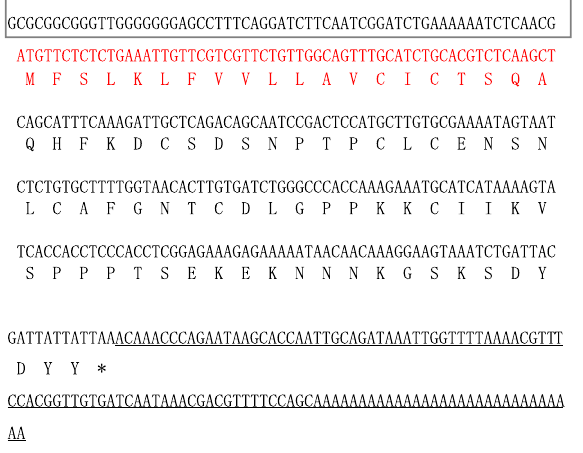
Figure 2. Full-length cDNA sequence of hirudin. (The signal peptide is marked in red; the initiation codon is shown in bold; the termination codon is indicated by an asterisk; 5 ′ -terminal untranslated region (UTR ) is shown in box; 3 ′ -terminal UTR is marked with a straight line; and the other parts represent the mature hirudin amino acid sequence).